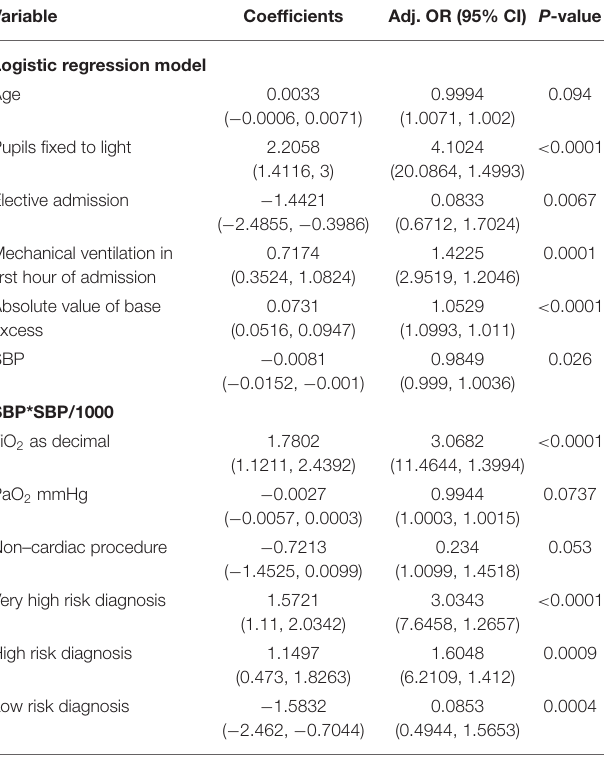
TABLE 3 | Logistic regression model. TABLE 4 | Recalibrated PIM3 model.